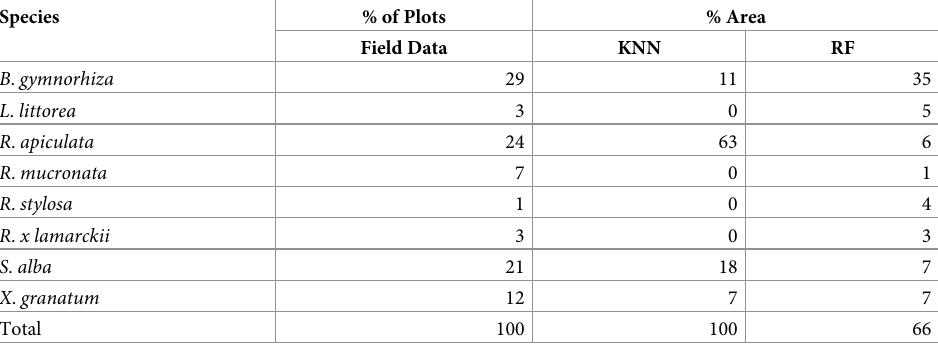
Table 1. Predicted species dominance.